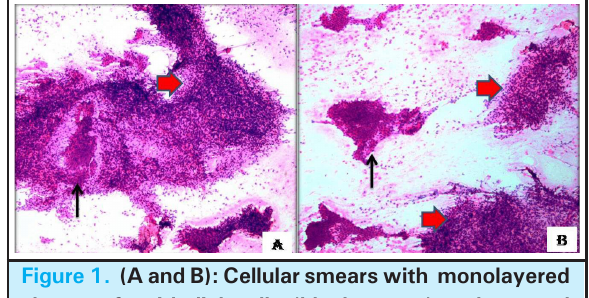
Figure 1. (A and B): Cellular smears with monolayered sheets of epithelial cells (black arrow) and stromal fragments. (Red arrow) [H&E x100]